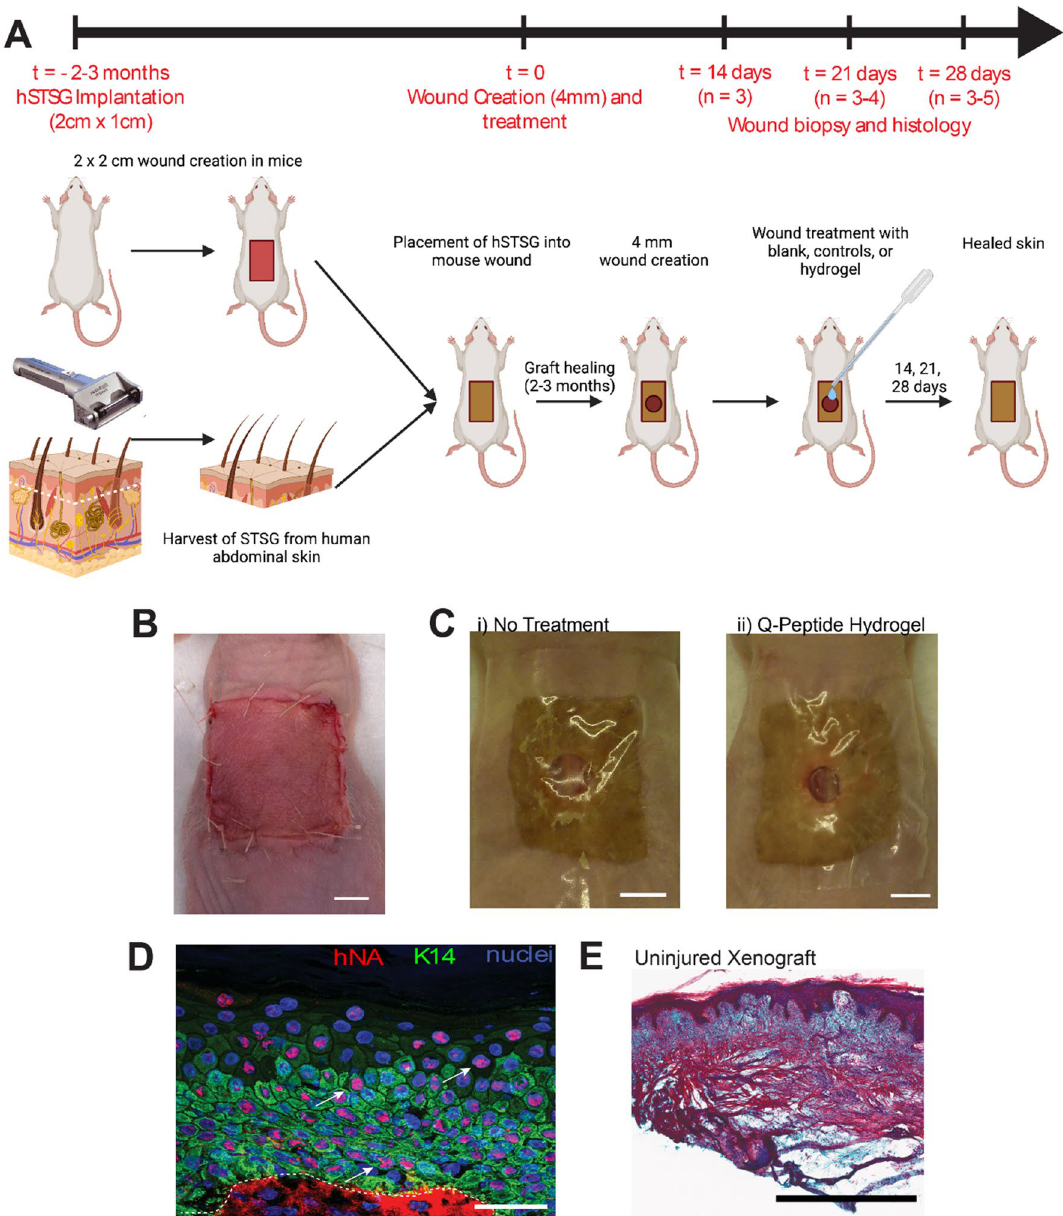
Figure 2. Wounds created in adult human split thickness skin xenografts display evidence of re-epithelialization with human epidermis. ( A ) Split thickness xenograft model. ( B ) Split thickness xenografts were harvested from donor human skin and grafted onto 2 × 2 cm full thickness defects created on the backs of nude (Nu/Nu) mice (scale bar = 0.5 cm). ( C ) After 3 months, accepted hSTSG were then wounded with a 4 mm biopsy punch and treatments immediately applied then maintained by covering with a semi-permeable adherent dressing (Tegaderm) throughout the duration of wound healing (scale bar = 0.5 cm). ( D ) Immunohistochemistry of healed wounds confirmed presence of human epidermis through double staining for keratin 14 (K14) to generally identify keratinocytes and human nuclear antigen (hNA, arrows) to specifically identify human keratinocytes in the center of a healed wound. Dashed line indicates basal epithelial layer (scale bar = 50 µm). ( E ) Masson’s Trichrome stained uninjured xenograft demonstrating the fibrotic dermis that is typically associated with this model. Scale bar = 1 mm. Created with Biorender.com